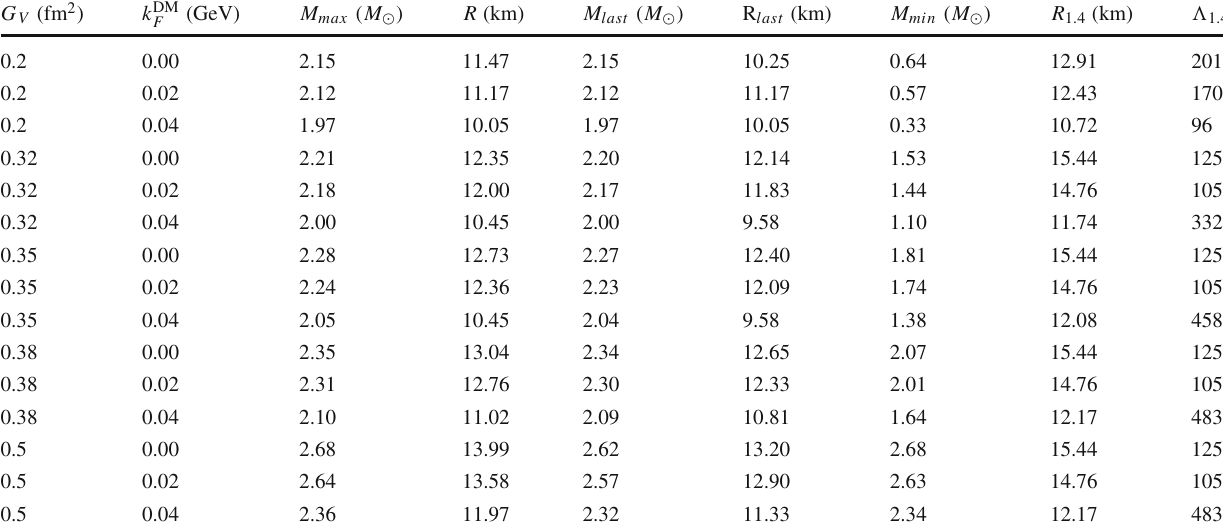
the radii and tidal deformability, R 1 . 4 and (cid:16) 1 . 4 , for different coupling constants of the vector MIT bag model, G V , and dark matter Fermi momentum, k DM